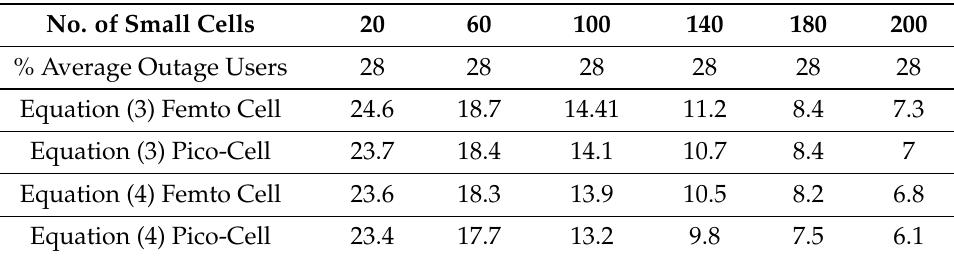
Table 4. Results from Equations (3) and (4) for Femto and Pico-cells deployment and remaining users in Outage in each